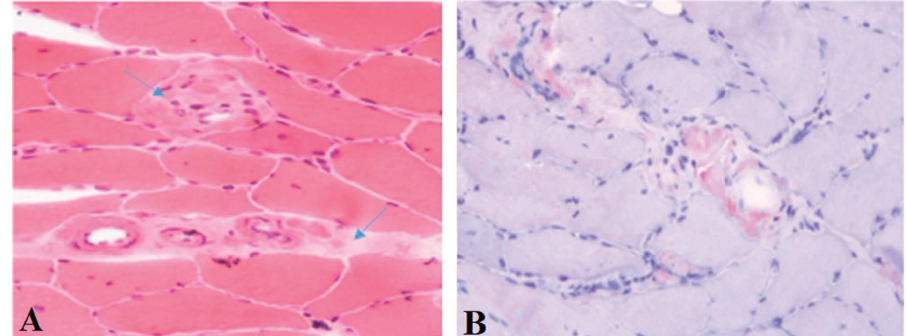
Figure 5: Muscle biopsy of the medial head of the gastrocnemius muscle demonstrating deposition of hyalinized amorphous extracellular eosinophilic material in vessel walls and endomysial connective tissue. (a) Hematoxylin and eosin. (b) Congo